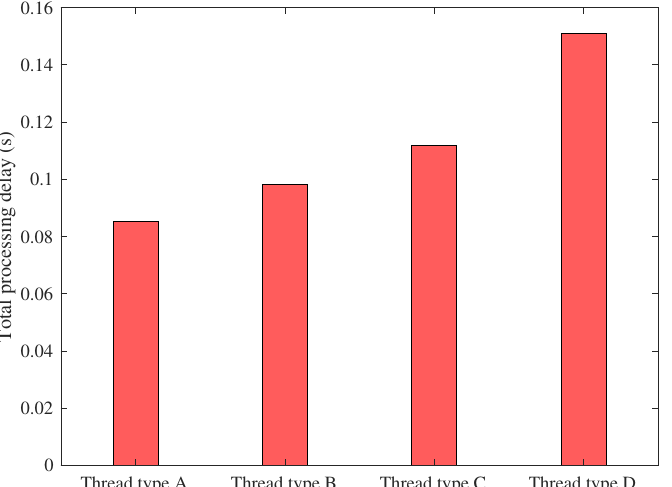
Figure 13. The effect of different computing resources on the total processing